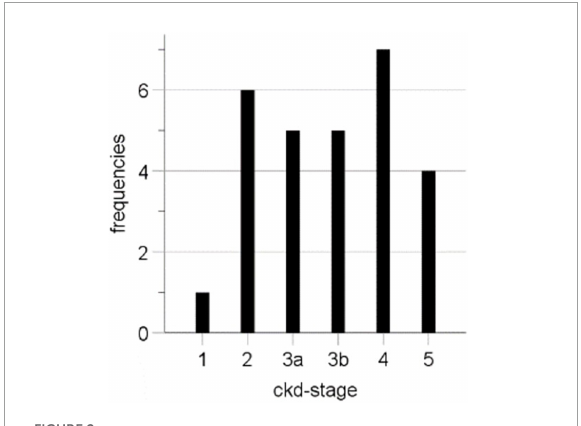
FIGURE2 CKD stages at CEUS of examined kidney transplants.